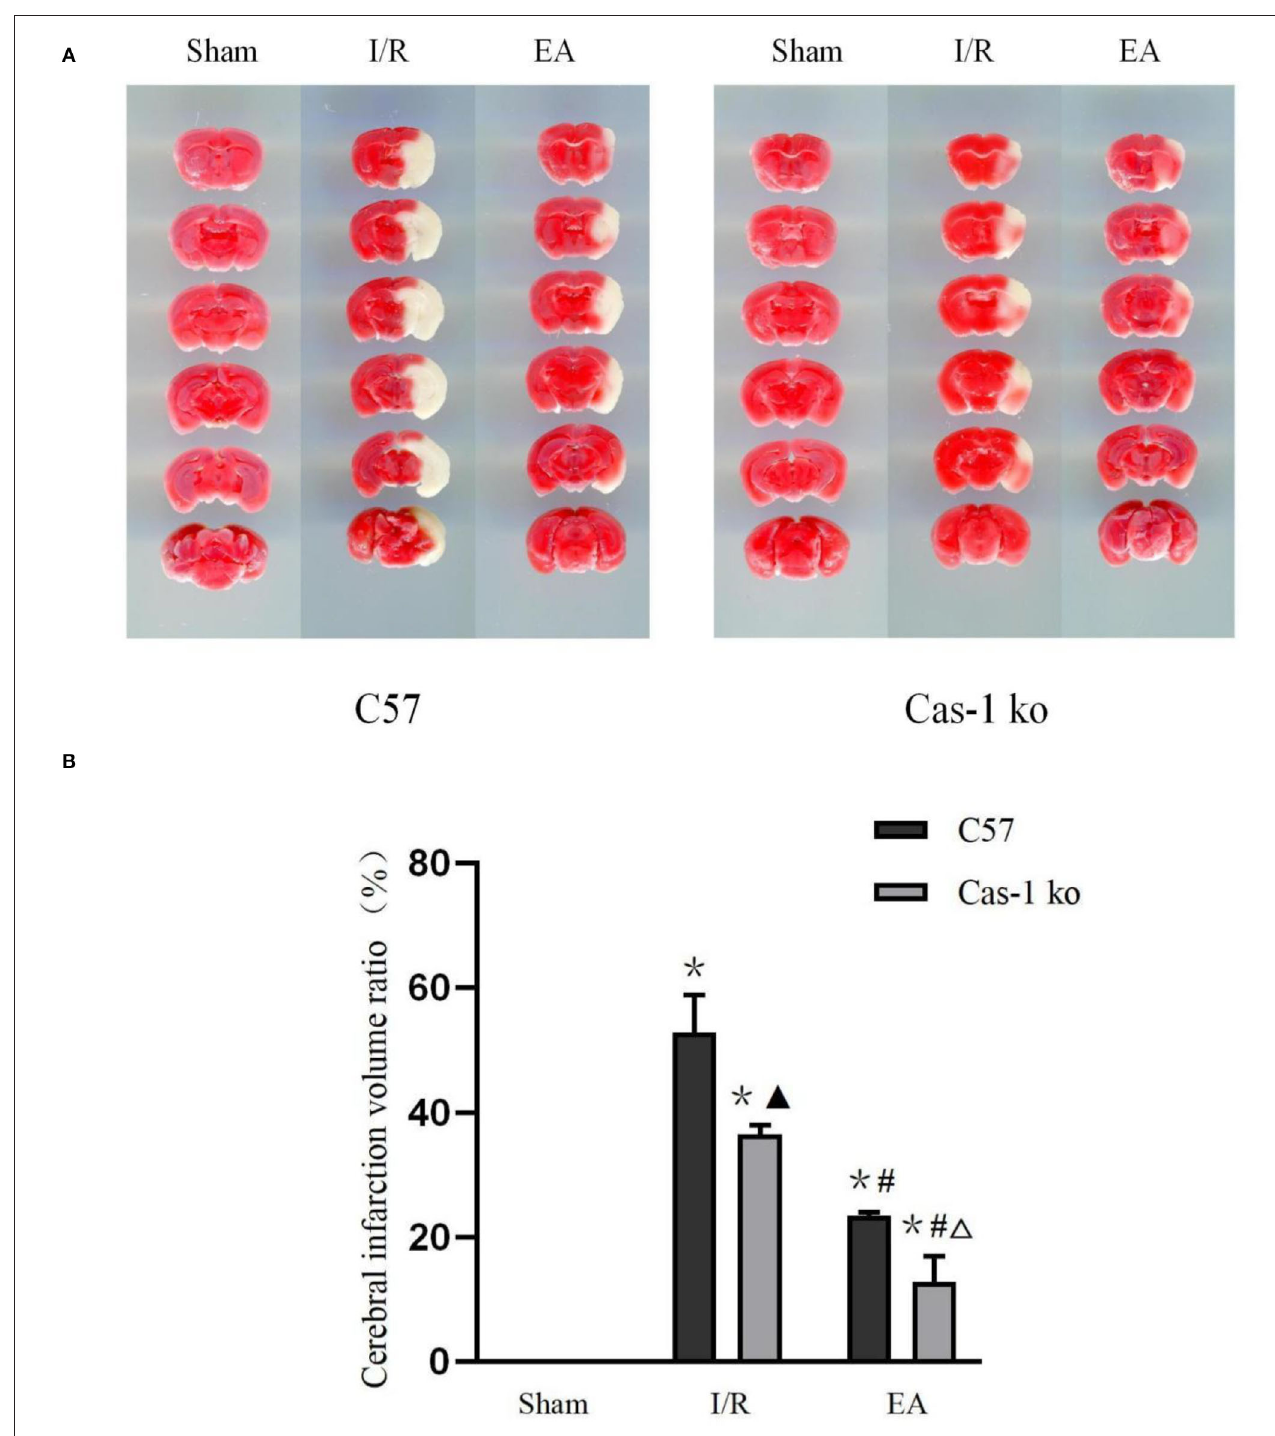
FIGURE 2 | Brain tissue with TTC staining. (A,B) TTC staining results of different treatment groups and quantitative analysis of volume ratio. Comparison within the same genotype: * p < 0.05 vs. Sham group; # p < 0.05 vs. I/R group. Comparison within the I/R group: N p < 0.05 vs. C57 mice. Comparison within the EA group: 1 p < 0.05 vs. C57 mice. Data are representative of four independent experiments [ (A,B) mean ± SD are representative of values from four independent experiments in (B) ].